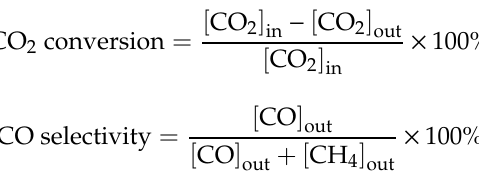
Figure S1: XRD patterns of the recycled NP-Co catalysts, Figure S2: XPS spectra of Co 2p for the recycled NP-Co catalysts, Figure S3: H 2 -TPR profile of the Co-400R-S1